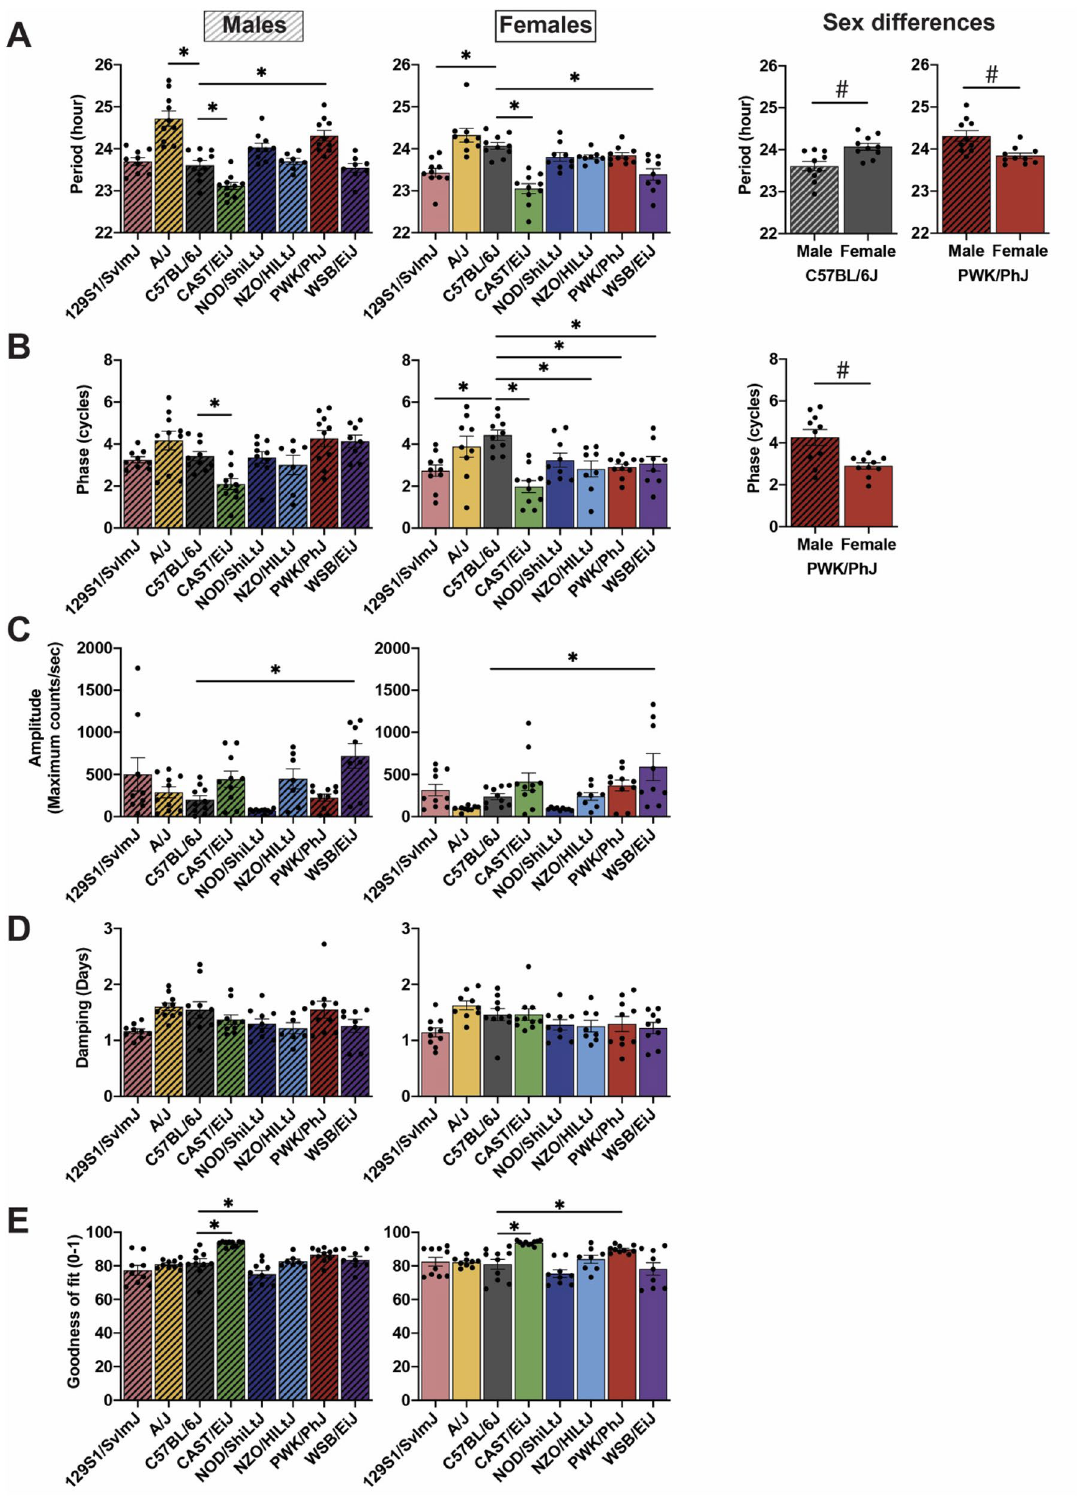
Figure 2. Strain and sex differences of ensemble Bmal1-dLuc rhythms in primary fibroblast cultures. Quantified data for strain and sex differences in (A) period, (B) phase, (C) amplitude, (D) damping rate and (E) goodness of fit of Bmal1-dLuc rhythms. Bar graphs depict mean ± SEM. Bar graphs with fill pattern indicate the data from males. Asterisks indicate that circadian parameters are significantly (P < 0.05) different compared to C57BL/6J within the same sex. Hashtags indicate significant (P < 0.05) sex differences in period and phase of Bmal1-dLuc